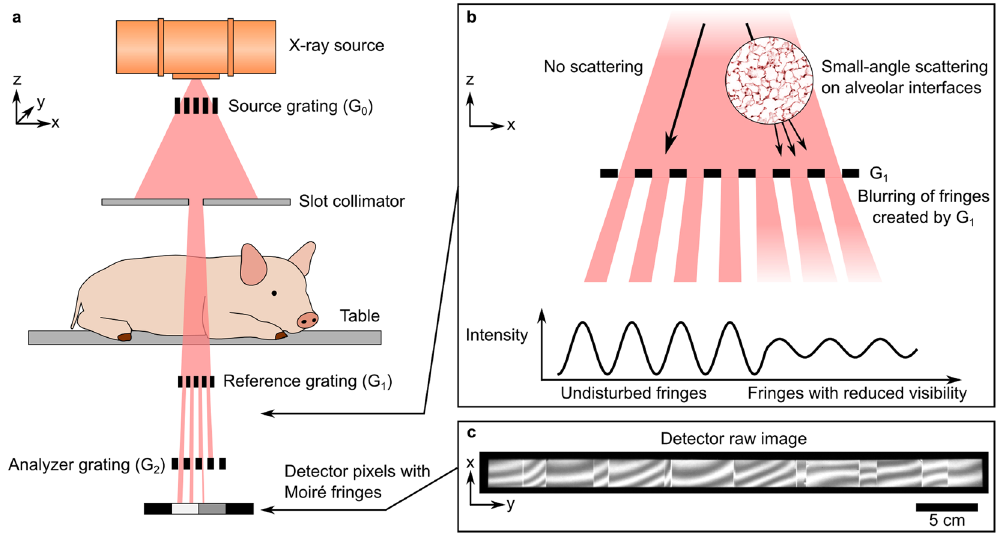
Figure 1. Full-field X-ray dark-field (XDF) chest radiography scanner. ( a ) Schematic of the prototype. A coarse array of Moiré fringes serves as a reference pattern created by a slight mismatch between the G 1 and G 2 grating orientation. The anesthetized pig is placed on a sample bed and scanned by a continuous movement. The influence of the sample on the Moiré fringe is used to calculate the XDF images. ( b ) In case of the lung, millions of micron-sized alveoli (more precisely their air-tissue interfaces) scatter the X-rays, causing a blurring and subsequent decrease of the G1 fringe visibility. ( c ) Raw detector image with the reference Moiré fringe pattern. Note that the vertical strikes arise from stitching together the borders of neighboring grating tiles and that the scale bar corresponds to the dimensions in the detector